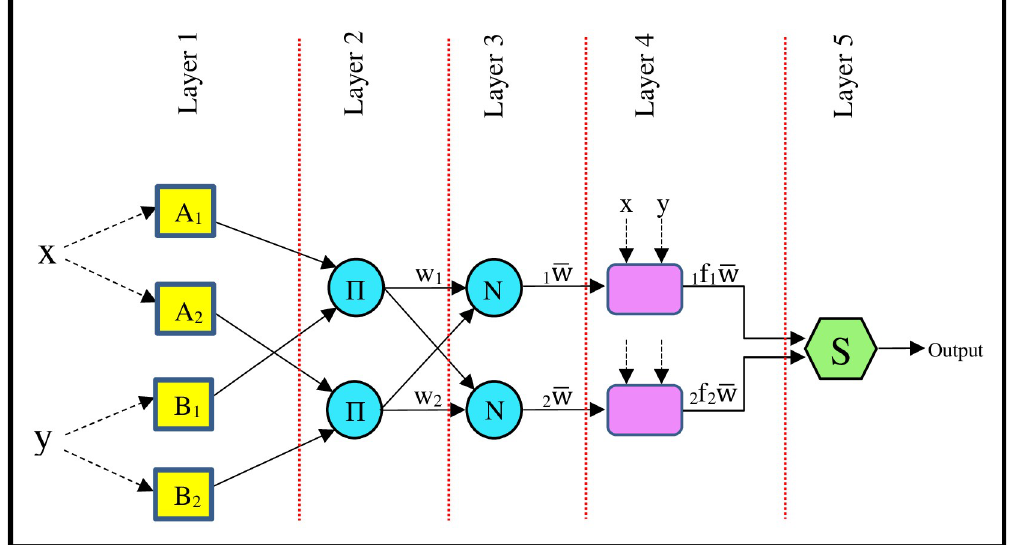
Fig 3. Architecture of adaptive neuro-fuzzy inference system (ANFIS) model with two input variables and one output variable.